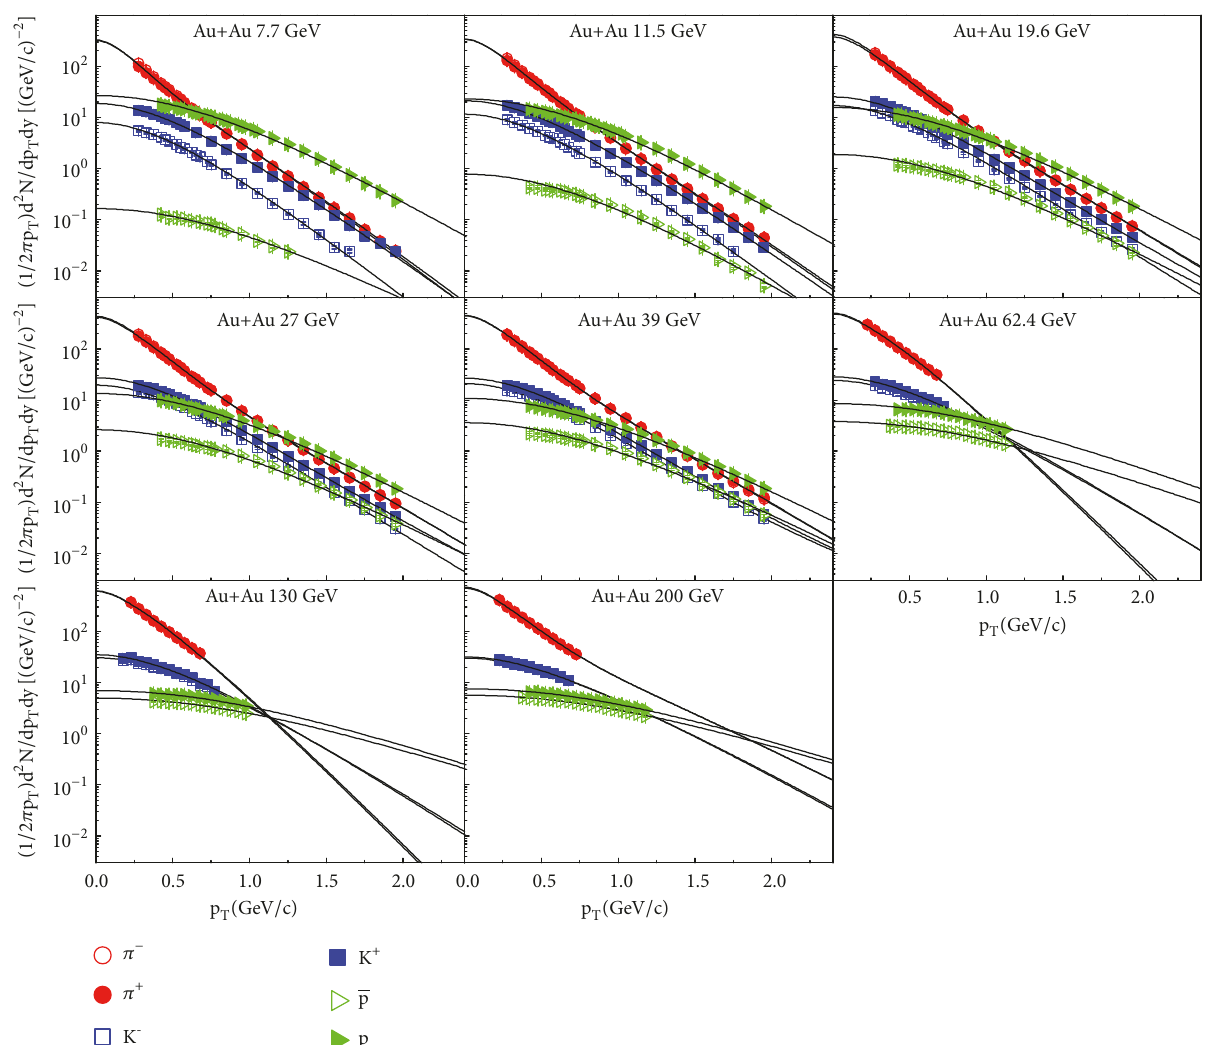
Figure 1: Midrapidity ( |𝑦| < 0.1 ) double-differential 𝑝 𝑇 spectra for 𝜋 − , 𝜋 + , 𝐾 − , 𝐾 + , 𝑝 , and 𝑝 in central Au+Au collisions at √𝑠 𝑁𝑁 = 7.7 , 11.5, 19.6, 27, 39, 62.4, 130, and 200 GeV, where the centrality interval at 130 GeV is 0–6% and at other energies is 0–5%. The different symbols representthemeasurementsdonebytheSTARexperiment[19,21]andthecurvesrepresenttheresultsfittedbythe(two-component)standard distribution. The values of parameters can be found in Table